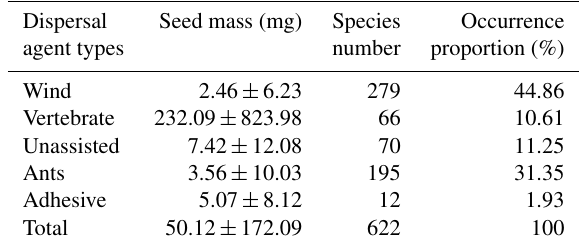
Table 3. Seed mass, species number and proportions of five disper- sal types in the whole study